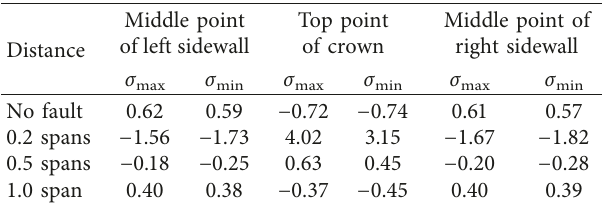
Table 2: Max stress and min stress in sprayed concrete layer under different